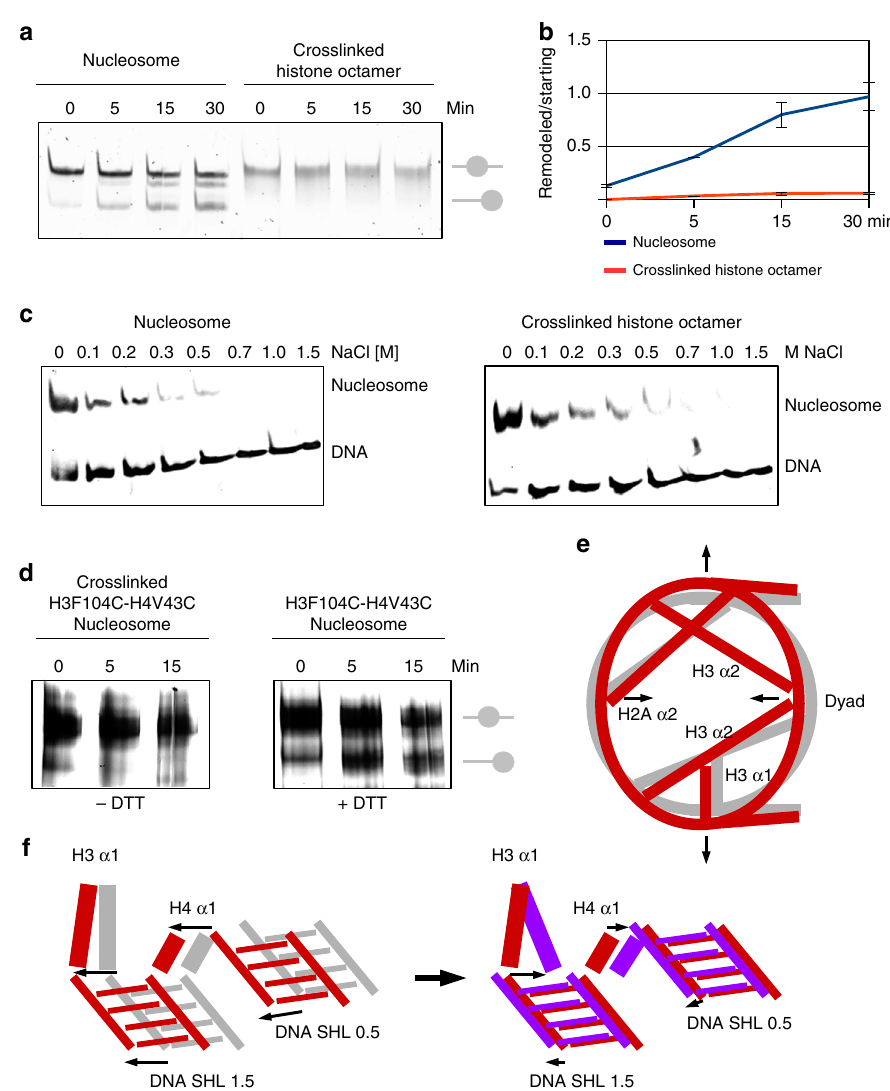
Fig. 5 Conformational rearrangement of the histone octamer is required for nucleosome sliding. a Thermal mobilization of nucleosomes on 227 bp DNA sequence containing 601 sequence in the middle. Native nuclesomes are re-positioned at 60 °C. Nucleosomes with cross-linked octamer did not move. b Quanti fi cation of three independent thermal shift assays showing that the cross-linked octamer does not move on DNA. The band intensity was quanti fi ed at starting and remodeled position at each time point. SD of three independent experiments is shown. c Salt-induced disassembly of native and cross-linked nucleosomes. Cross-linked nucleosomes disassemble at elevated salt concentration, indicating that histone octamer did not cross-link with the DNA. d Thermal mobilization of nucleosomes on 227 bp DNA sequence containing 601 sequence in the middle. NCP with the disul fi de bridge between H3 F104C and H4 V43C is immobilized in the thermal shift assay. Upon addition of the reducing agent (DTT), nucleosomes are mobile again. e Model showing the conformational changes in the histone octamer that lead to nucleosome distortion. Tilting of the long α 2 helices of H3, H2A, and H2B contracts the nucleosome along the symmetry axis and stretches the nucleosome in the perpendicular direction. This rearrangement of the octamer also moves the DNA. DNA gyres move by > 4 Å at SHL 1.5 – 2.5 and SHL 5.5 – 6.5. Canonical nucleosome is shown in gray, distorted in red. f Model showing DNA translocation at SHL 2. In the fi rst step of DNA translocation, DNA and the H3/H4 α 1 helices move > 4 Å, leading to nucleosome distortion (Class 2). In the next step, the H3 α 1 dissociates from the DNA and translocates to DNA strand, which was previously bound by the H4 α 1. The H4 α 1 detaches from the DNA at SHL 1.5 and binds the DNA at SHL 0.5. This leads to translocation of the DNA by the histone octamer at SHL 2. The DNA is pushed further and moves by > 5 Å when compared with X-ray structures. Arrows indicate direction of the movement. Canonical nucleosome is shown in gray, distorted in red, and translocated in